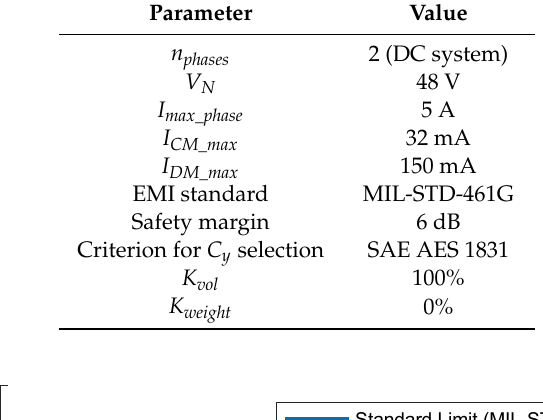
Table 2. Input parameters for filter design for the chosen case study.